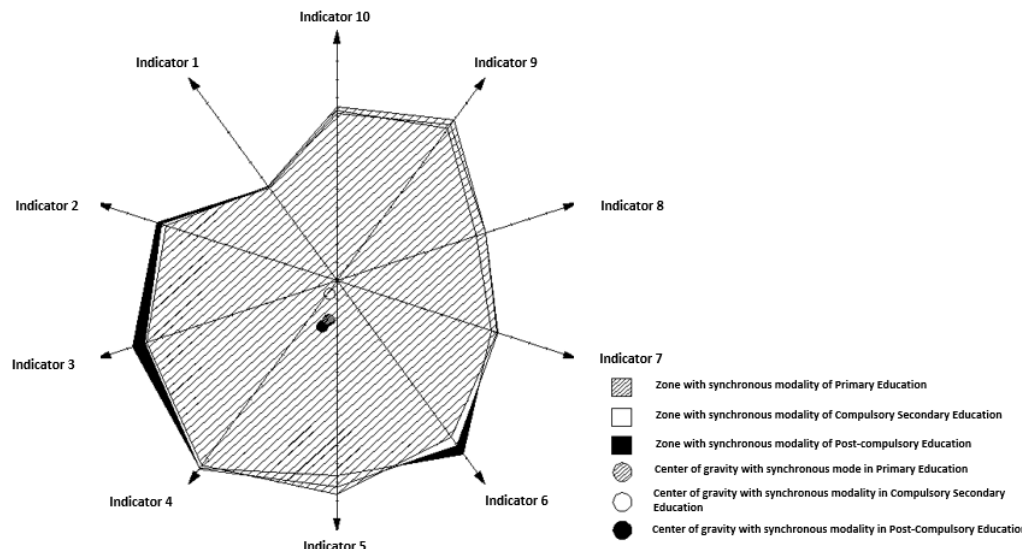
Figure 4. Graphical representation of the area of importance and the center of gravity in the super- vision of the indicators of the SULODITOOL ® tool in asynchronous mode and in all teaching sce- narios (scenarios 1, 3 and 5). Source: own elaboration through the AutoCAD ® application.